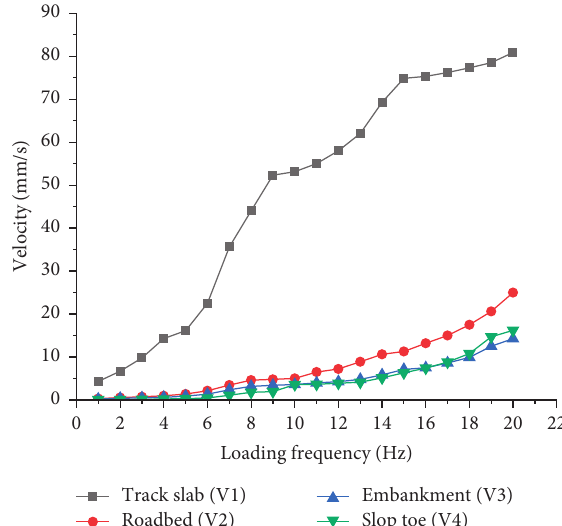
Figure 13: Relation between surface vibration velocity and loading frequency in the model test.